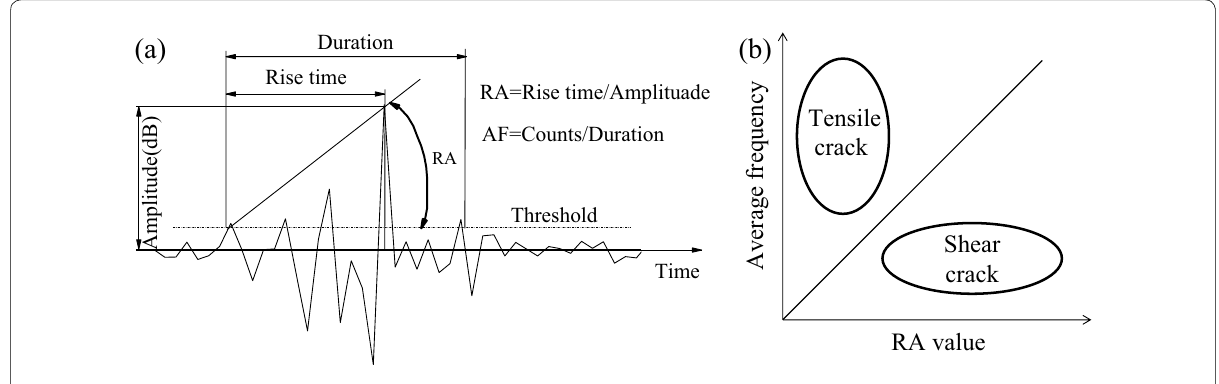
Fig. 11 a Typical crack classification; b Definition parameters of AE hits and